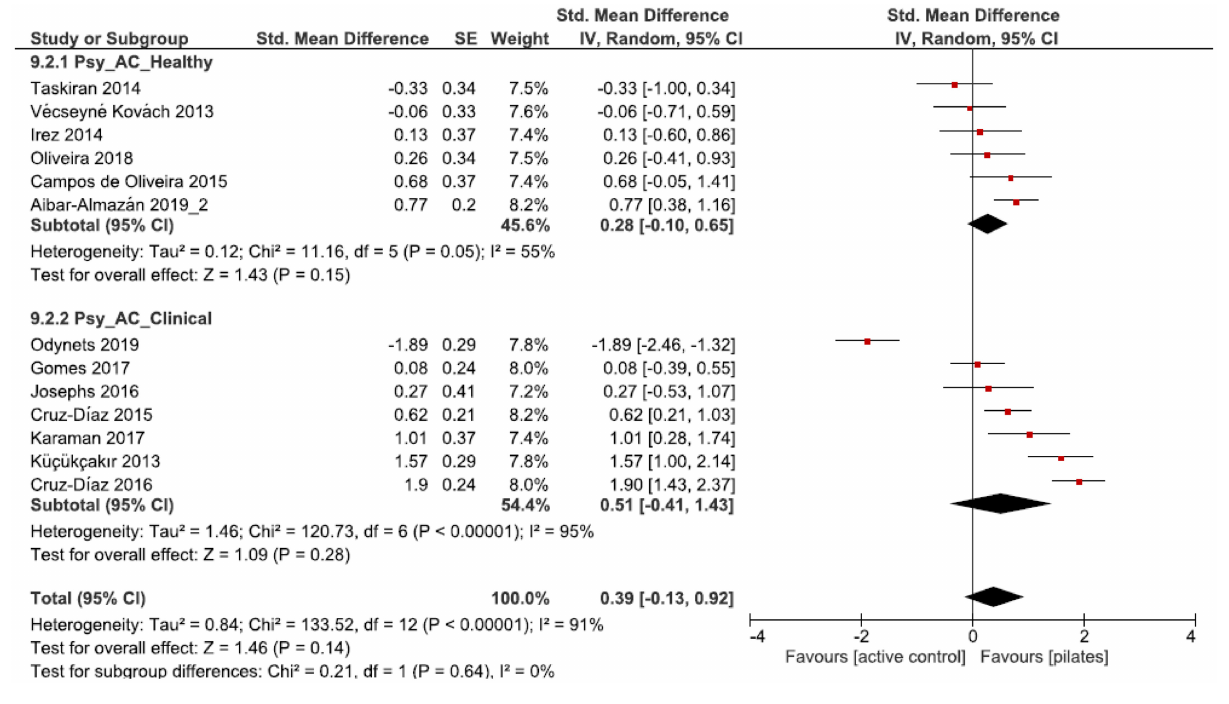
FIGURE 7 | Forest plot of standardized mean effects of Pilates intervention on psychological health parameters compared to active control groups. Data are presented for healthy older adults and older adults with clinical conditions. SE, standard error; IV, inverse variance model; CI, confidence interval; Std.,